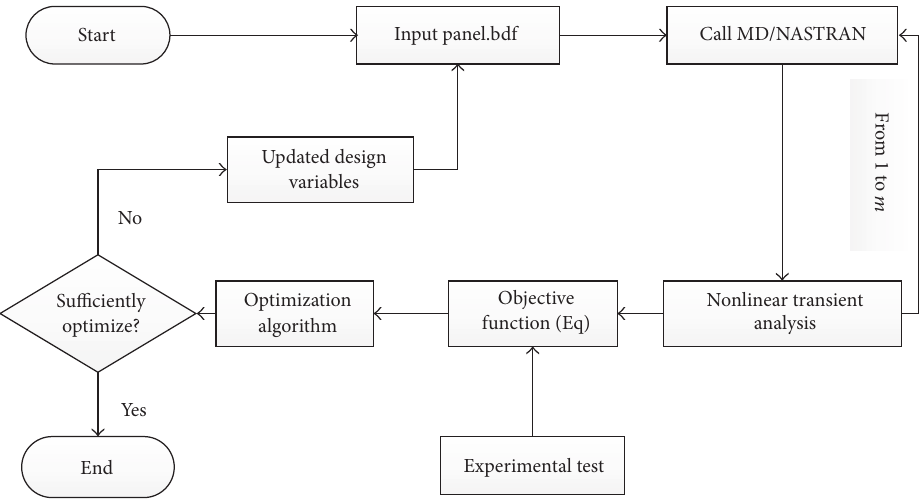
Figure 5: Flowchart of the optimization